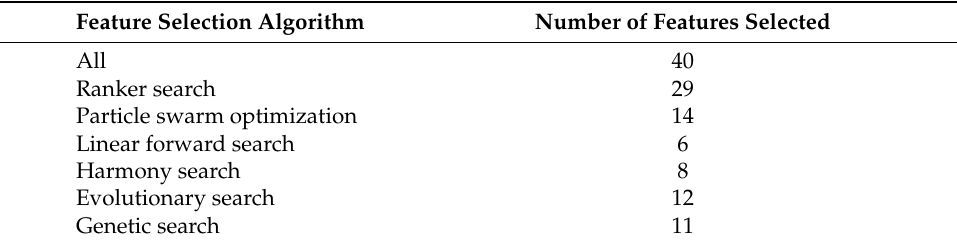
Table 1. Number of features selected by each feature selection